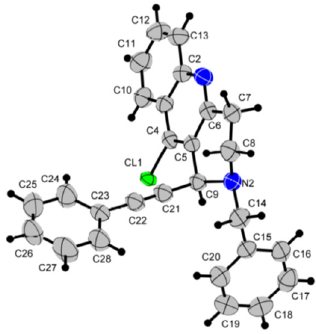
Figure 2. Single crystal X-ray analysis of compound 5a (crystallographic data in Supplementary Materials).